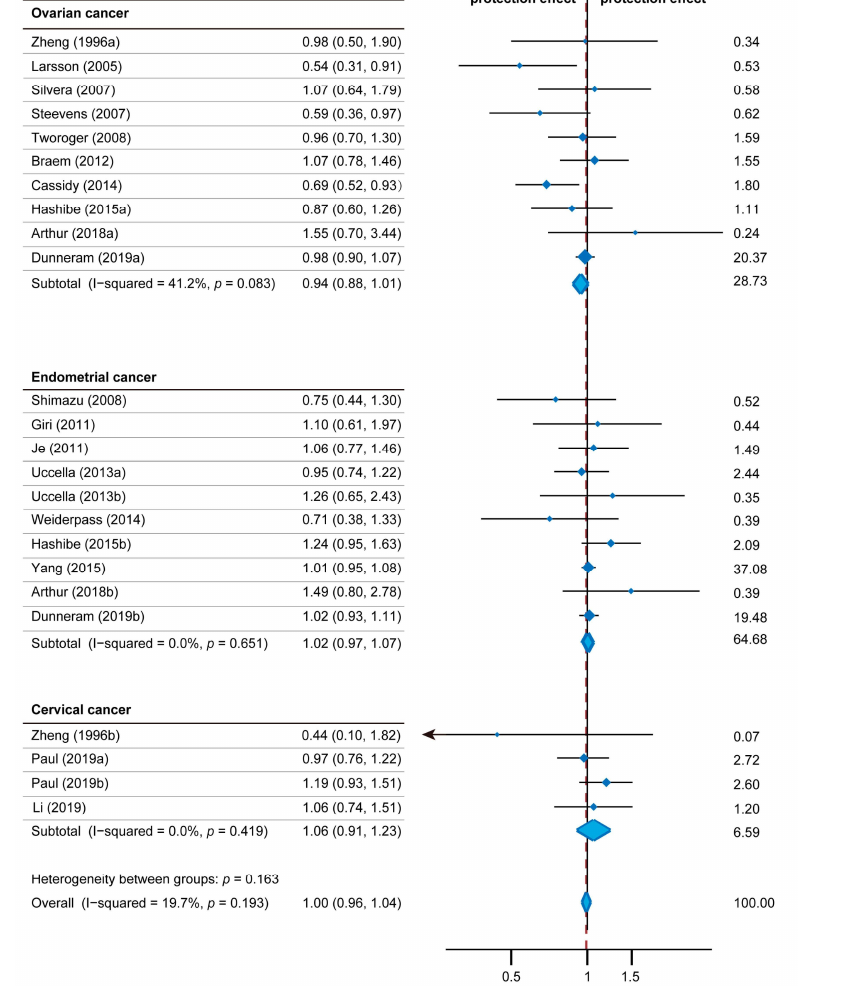
Figure 2. Forest plot of association between tea intake and gynecologic tumor risk. I-squared ≥ 50% represents substantial heterogeneity. RR—Relative risk; CI—Confidence intervals [14,30–40,42–47]. Table 2. Subgroup analyses of association between tea consumption and gynecologic tumor